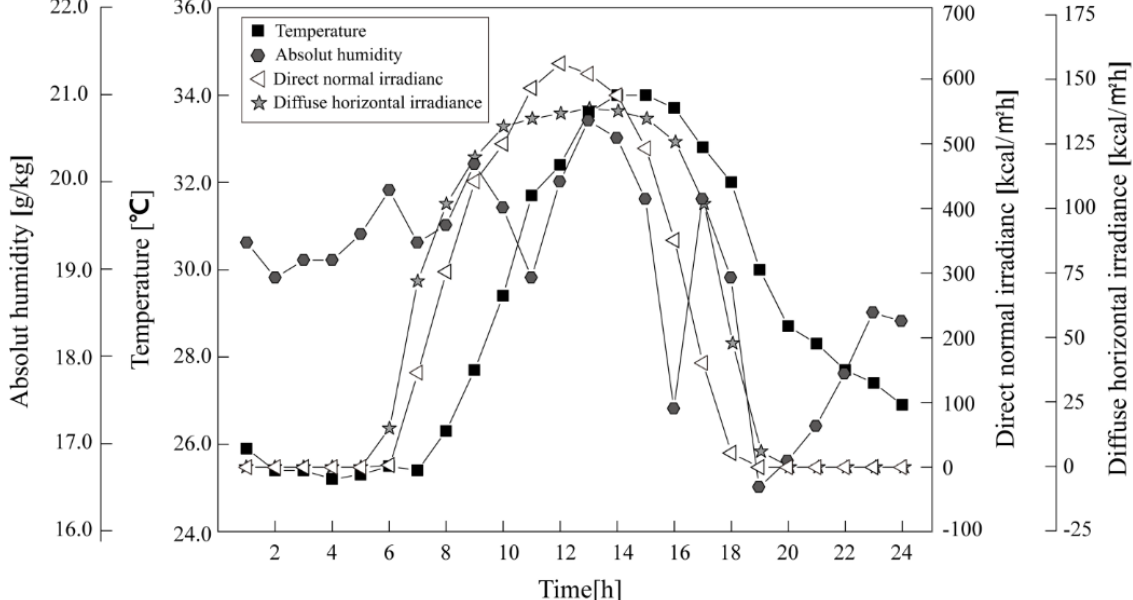
Figure 2. Weather conditions for outdoor thermal environment simulation.